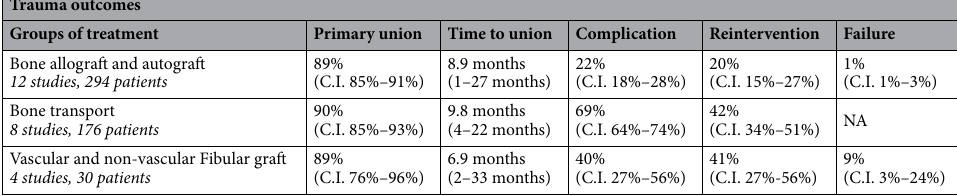
Table 4. Summary of trauma studies outcomes.